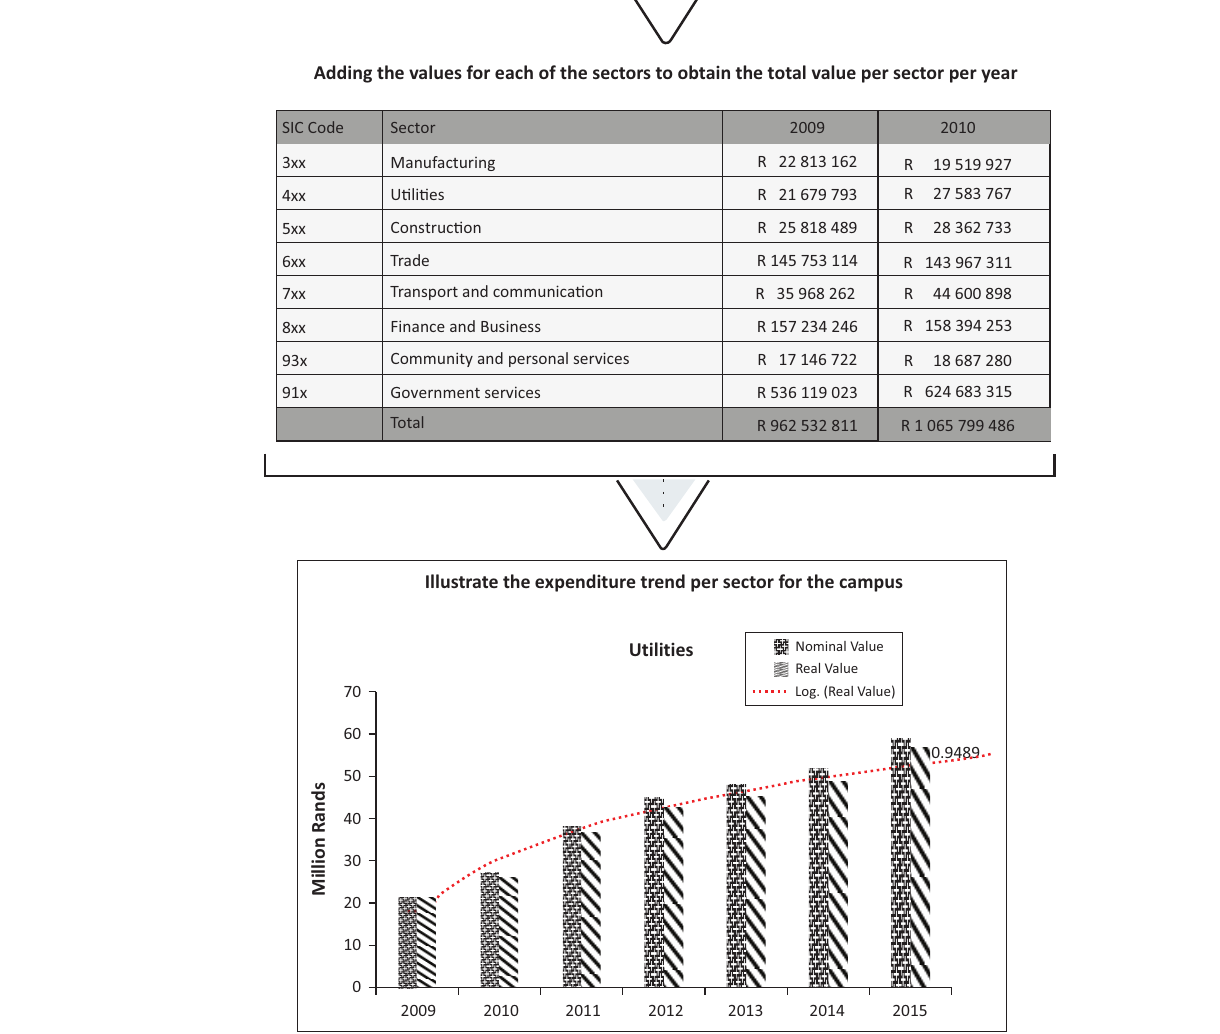
FIGURE 4: Campus expenditure to sector